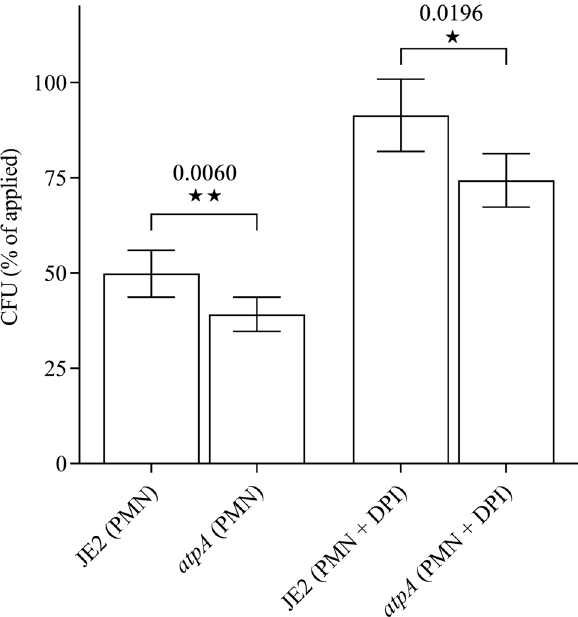
Figure 3. Neutrophil-mediated killing of S. aureus . The percentage of viable opsonized WT and atpA mutant cells following incubation with neutrophils (PMN) for 1 h. Surviving cells are expressed in percentage of the initial counts. Diphenyleneiodonium (DPI) is a NADPH oxidase inhibitor. Each value provided is the mean ± SEM derived from at least seven independent measurements. p < ★★★